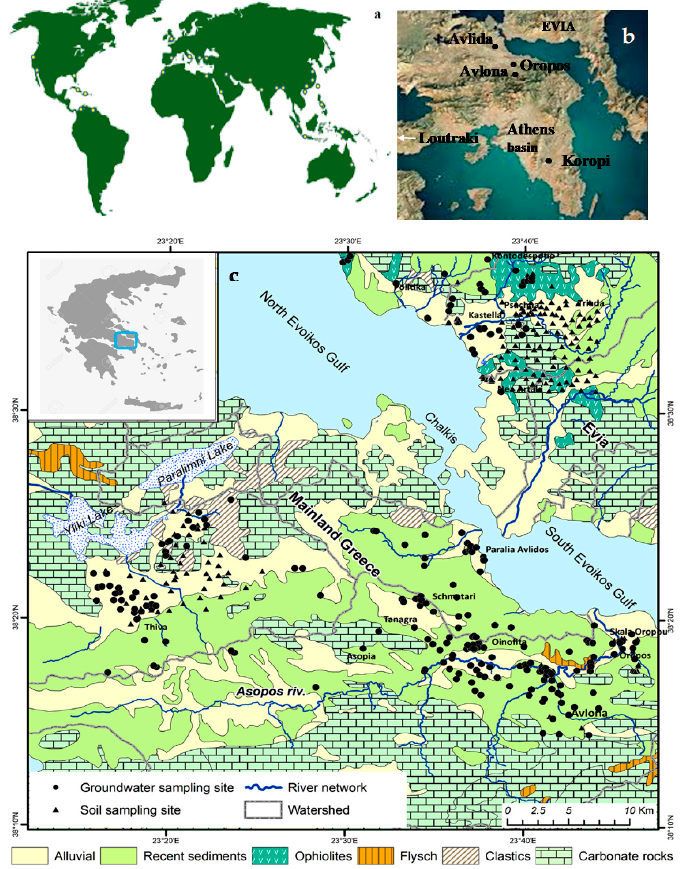
Figure 3. Sketch map showing locations of contaminated groundwater by Cr(VI) coasts ( a )